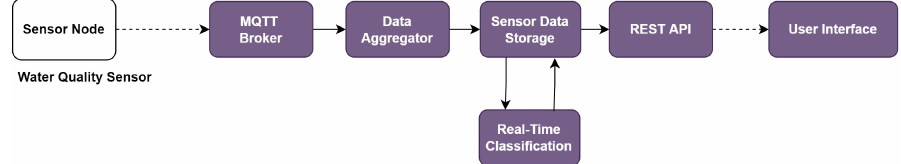
Figure 10. Function flow for water quality monitoring system in platform.